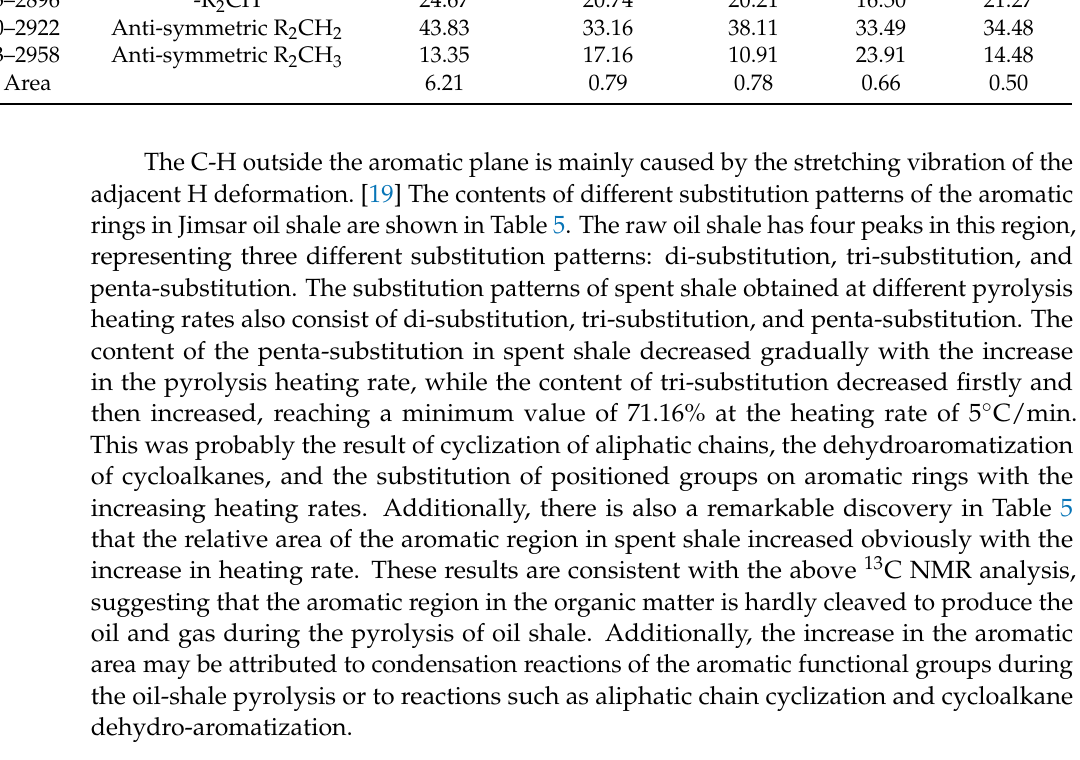
Table 5. Variation of functional groups during pyrolysis in the aromatic region of the Jimsar oil